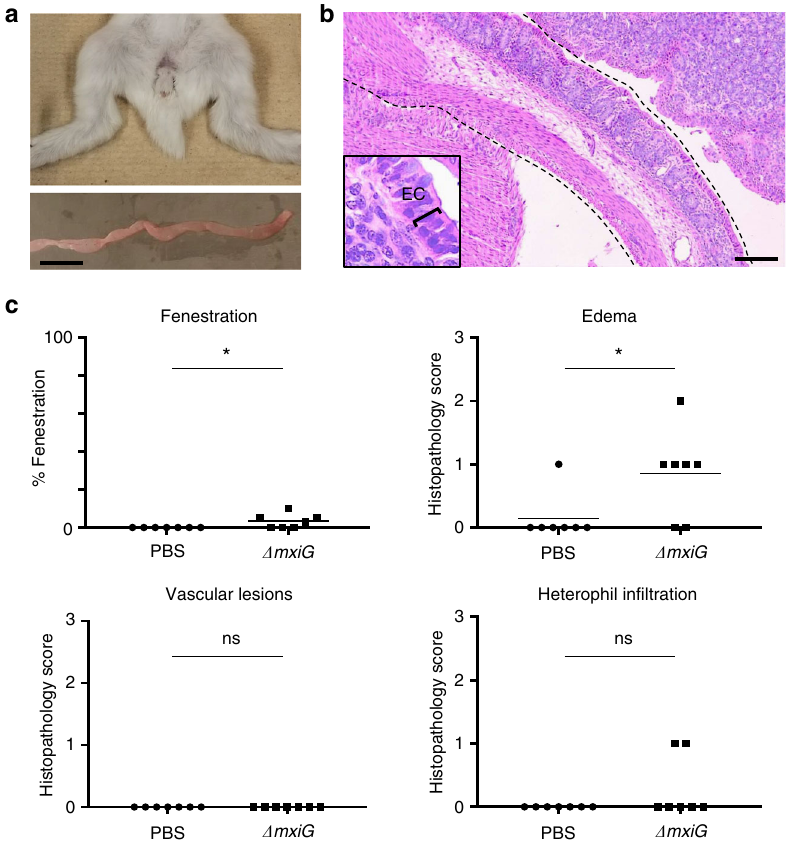
Fig. 4 Symptoms and histopathology in absence of intracellular invasion. a Representative images of animals (top) and colon (bottom) inoculated with the Δ mixG mutant. Scale bar, 2 cm. b Representative image of hematoxylin- and eosin-stained colonic sections from animals inoculated with the Δ T3SS mutant. Dotted lines delineate the colon. Inset: high-magni fi cation of epithelial cells (ECs). Scale bars, 100 μ m. c Percentage of epithelial fenestration (EF), and histopthology scores of edema (E), vascular lesions (VLs), and heterophil in fi ltration (HI). Statistical analysis, unpaired t test. Δ mxiG vs. mock (phosphate- buffered saline (PBS)): EF, * P < 0.05; E, * P < 0.05; VL, ns; HI, ns (not signi fi cant). Source data are provided as a Source Data fi